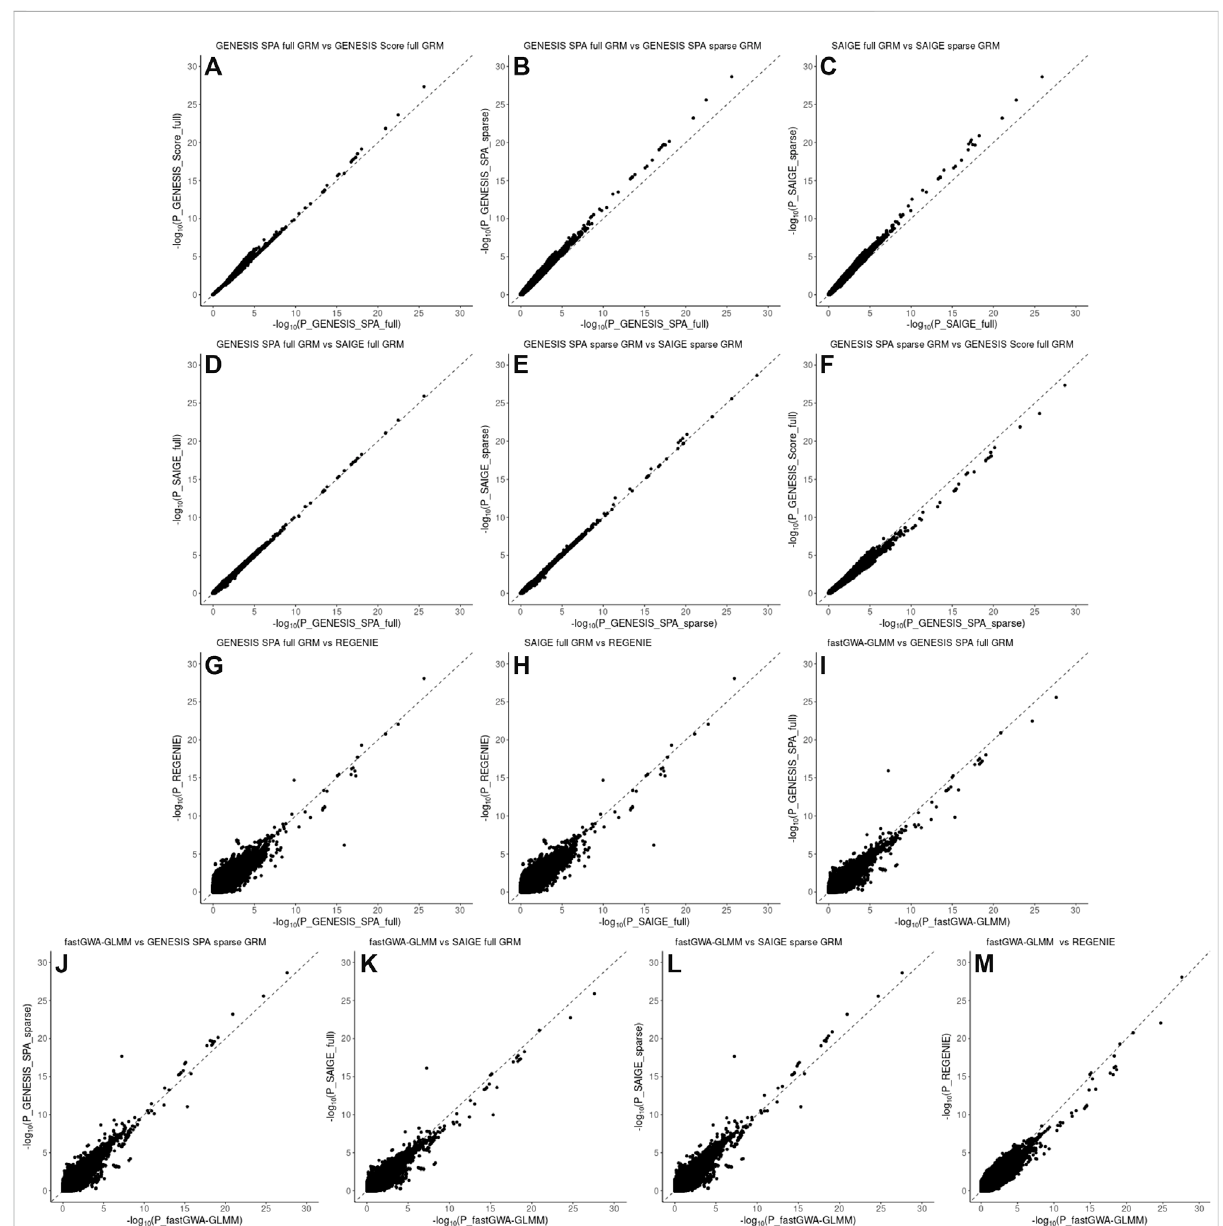
FIGURE 3 Pairwisecomparisonplotsof – log10( p values)fortheassociationsusingimputedgenotypedataintheNECSdata.Panel (A) :comparisonoftheassociations basedontheSPAandadjustedforthefullgeneticrelationmatrix(GRM)usingGENESISonthe X axisversusassociationsbasedonthescoretestandadjustedfor thefullGRMusingGENESISonthe Y axis.Panel (B) :comparisonoftheassociationsbasedontheSPAandadjustedforthefullGRMusingGENESISonthe X axis versusassociationsbasedontheSPAandadjustedforthesparseGRMusingGENESISonthe Y axis.Panel (C) :comparisonoftheassociationsbasedonthe SPAandadjustedforthefullGRMusingSAIGEonthe X axisversusassociationsbasedontheSPAandadjustedforthesparseGRMusingSAIGEonthe Y axis.Panel (D) :comparisonoftheassociationsbasedontheSPAandadjustedforthefullGRMusingGENESISonthe X axisversusassociationsbasedontheSPAandadjusted forthefullGRMusingSAIGEonthe Y axis.Panel (E) :comparisonoftheassociationsbasedontheSPAandadjustedforthesparseGRMusingSAIGEonthe X axis versusassociationsbasedontheSPAandadjustedforthesparseGRMusingGENESISonthe Y axis.Panel (F) :comparisonoftheassociationsbasedontheSPAand adjustedforthesparseGRMusingGENESISonthe X axisversusassociationsbasedonthescoretestandadjustedforthefullGRMusingGENESISonthe Y axis. Panel (G) :comparisonoftheassociationsbasedontheSPAandadjustedforthefullGRMusingGENESISonthe X axisversusassociationsbasedontheSPAand polygeniceffectestimatestocontrolforrelatednessusingREGENIEonthe Y axis.Panel (H) :comparisonoftheassociationsbasedontheSPAandadjustedforthe full GRM using SAIGE on the X axisversusassociations basedonthe SPA andpolygeniceffectestimates to control for relatednessusing REGENIE on the Y axis. Panel (I) :comparisonoftheassociationsbasedontheSPAandadjustedforthefullGRMusingfastGWA-GLMMonthe X axisversusassociationsbasedontheSPA and adjusted for the full GRM using GENESIS on the Y axis. Panel (J) : comparison of the associations based on the SPA and adjusted for the full GRM using fastGWA-GLMMonthe X axisversusassociationsbasedontheSPAandadjustedfor thesparseGRMusingGENESISonthe Y axis. Panel (K) :comparisonofthe associations based on the SPA and adjusted for the full GRM using fastGWA-GLMM on the X axis versus associations based on the SPA and adjusted for the full GRMusingSAIGEonthe Y axis.Panel(L):comparisonoftheassociationsbasedontheSPAandadjustedforthefullGRMusingfastGWA-GLMMonthe X axisversus associationsbasedontheSPAandadjustedforthesparseGRMusingSAIGEonthe Y axis.Panel(M):comparisonoftheassociationsbasedontheSPAandadjusted forthefullGRMusingfastGWA-GLMMonthe X axisversusassociationsbasedontheSPAandpolygeniceffectestimatestocontrolforrelatednessusingREGENIE on the Y